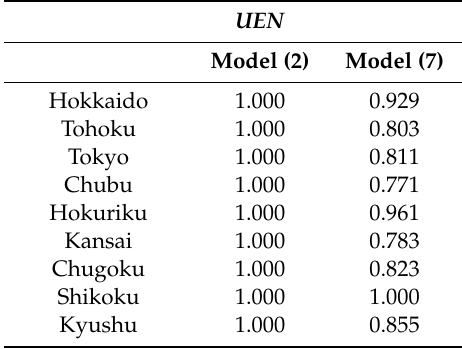
Table 6. Unified e ffi ciency measures on electric power companies using 2015